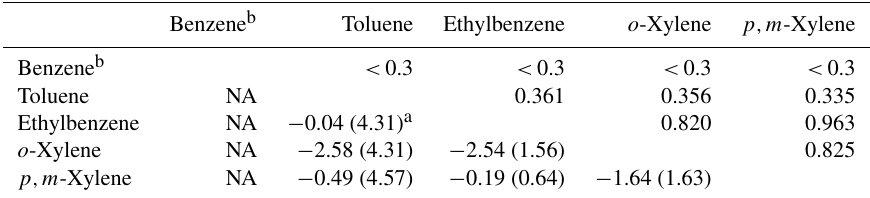
Table 9. Regression analysis of delta values. Values above diagonal are R 2 , and those below are the intercepts. Benzene b Toluene